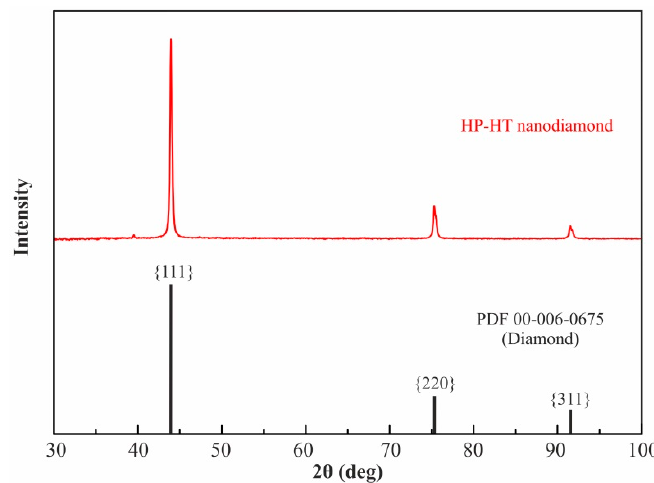
Figure 2. X-ray di ff raction pattern of HP-HT nanodiamond powder and X-ray di ff raction pattern of Figure 2. X-ray diffraction pattern of HP-HT nanodiamond powder and X-ray diffraction pattern of diamond (Powder Di ff raction File diamond (Powder Diffraction File 00-006-0675).